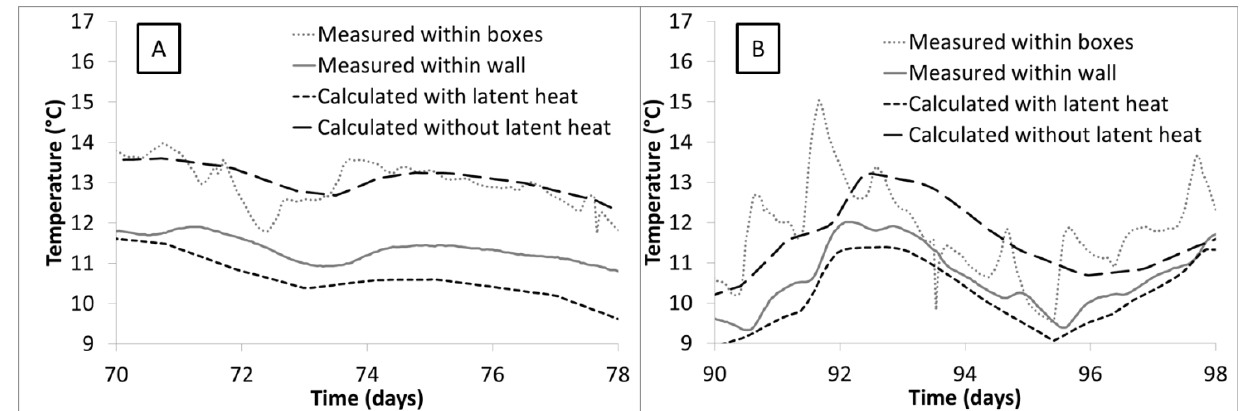
Figure 8. Focus on the temperature within the wall and within the boxes during ( A ) a drying stage and ( B ) a forced drying